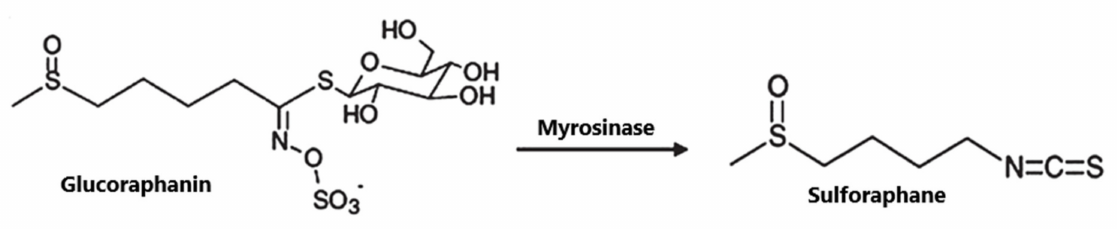
Figure 1. Schematic diagram of the formation of sulforaphane (SFN) (based on [74]